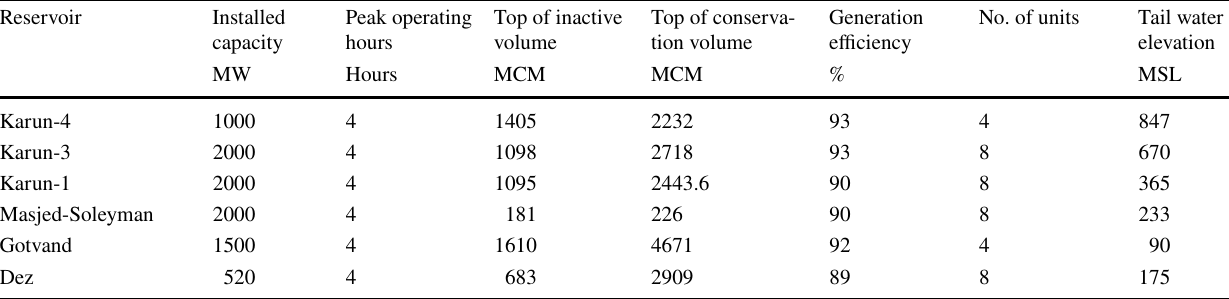
Table 1 General characteristics of reservoirs